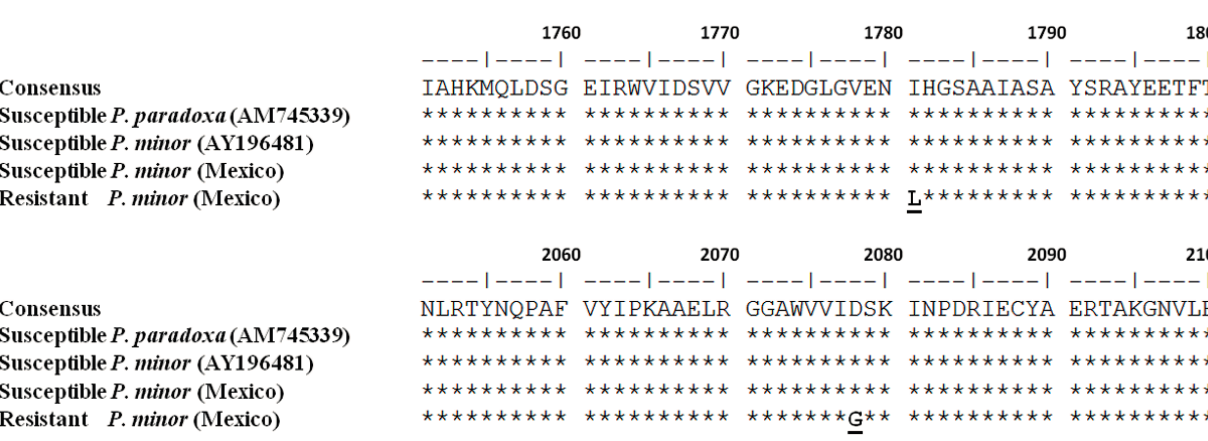
Figure 3. Alignment of partial amino acid sequences of chloroplastic homomeric ACCase from various grass species. The substitution in the resistant biotype of P. minor from Mexico is shown in